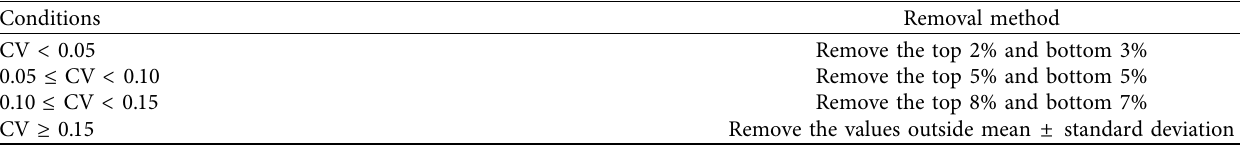
Table 2: Outlier removal method of Korea Expressway